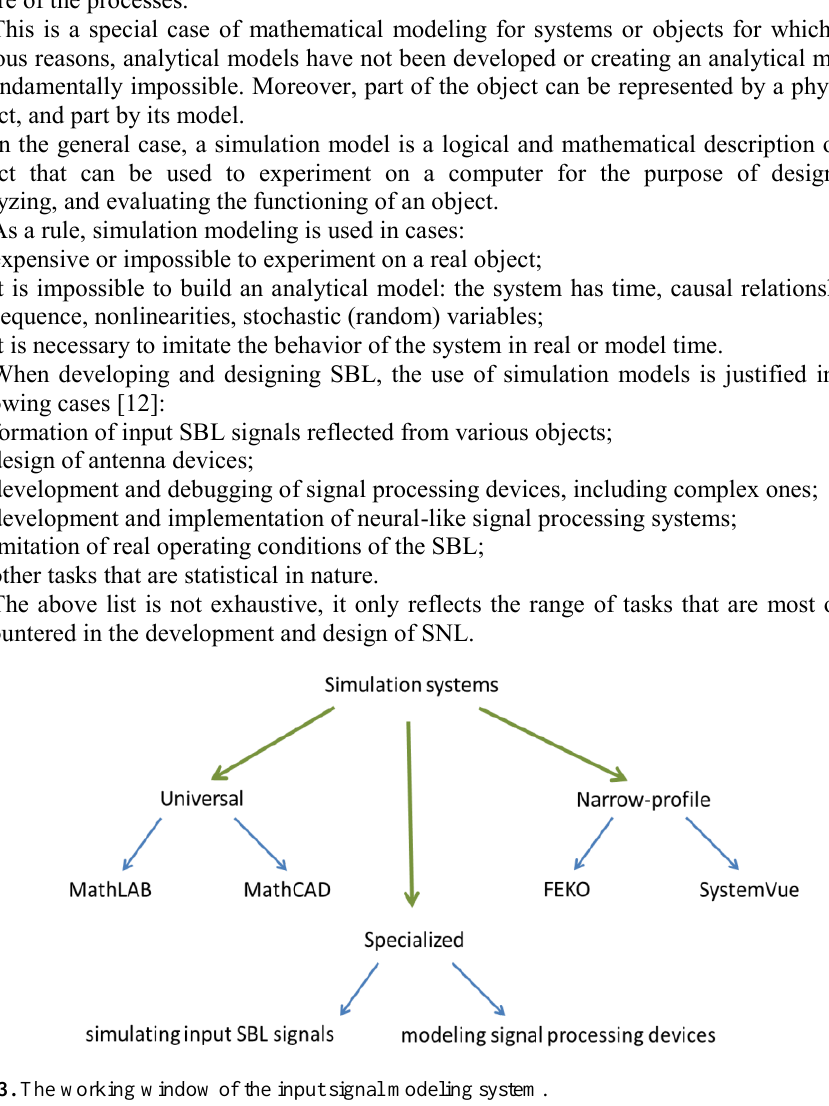
Fig. 3. The working window of the input signal modeling